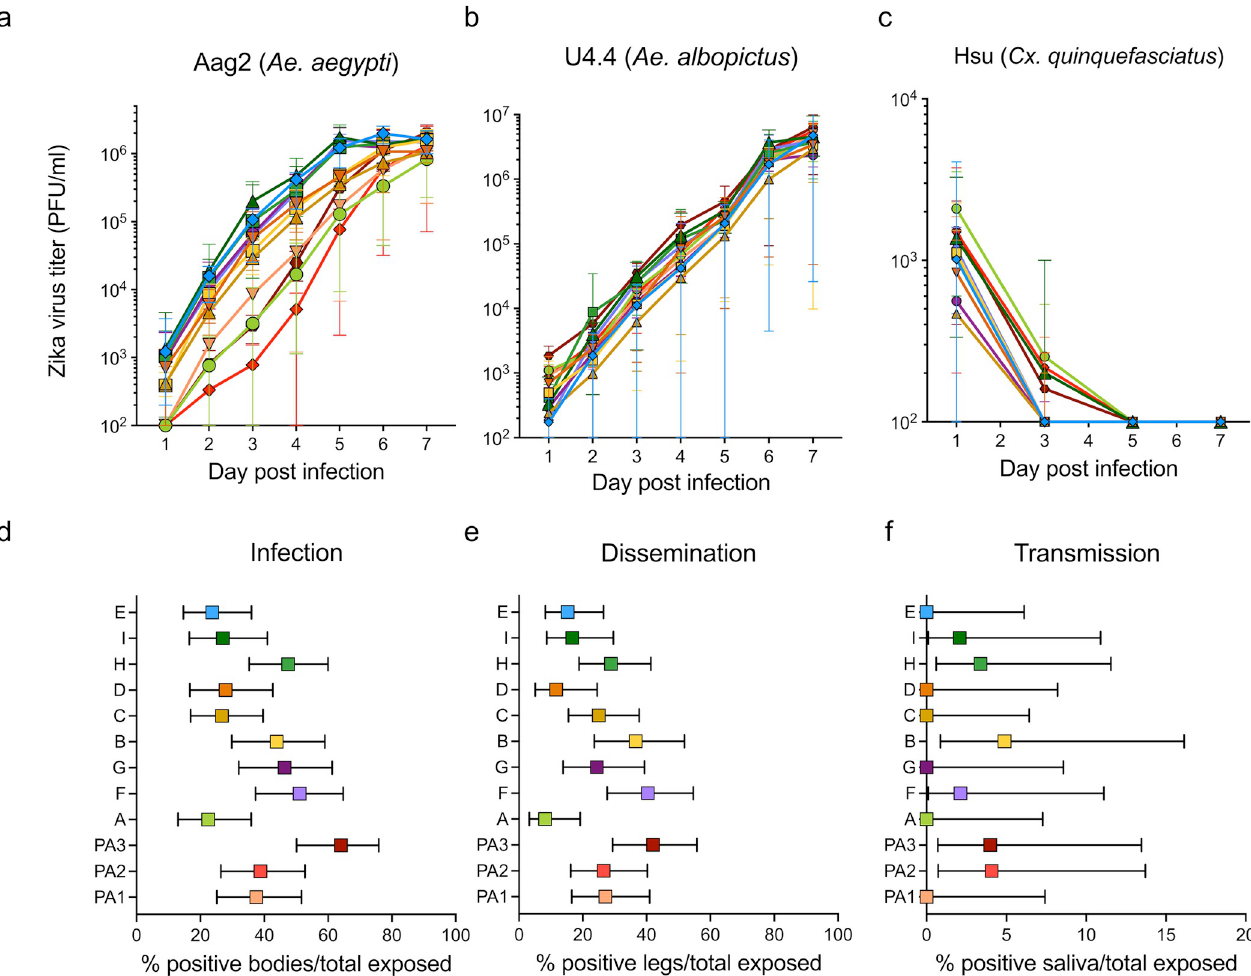
Fig 4. Evaluation of Zika virus fitness in three mosquito cell lines and in Ae . aegypti mosquitoes. Replicative fitness of 12 Zika virus clades among infected ( a ) Aag2 ( Ae . aegypti ), ( b ) U4.4 ( Ae . albopictus ), and ( c ) Hsu ( Culex quinquefasciatus ) cells for 3–5 replicates at a multiplicity of infection of 0.1. Shapes represent mean titers with error bars depicting the range. In vivo fitness of the 12 Zika virus clades by feeding Ae . aegypti mosquitoes (Poza Rica, Mexico) with infectious blood meals. ( d ) Infection (percent females with Zika virus-infected body out of the total number exposed females), ( e ) dissemination (percent females with Zika-virus infected legs and wings out of the total number of exposed females), and ( f ) transmission rates (percent females with Zika-virus infected saliva out of the total number of exposed females). Dots represent the rates expressed as percentages and error bars depict the 95% confidence